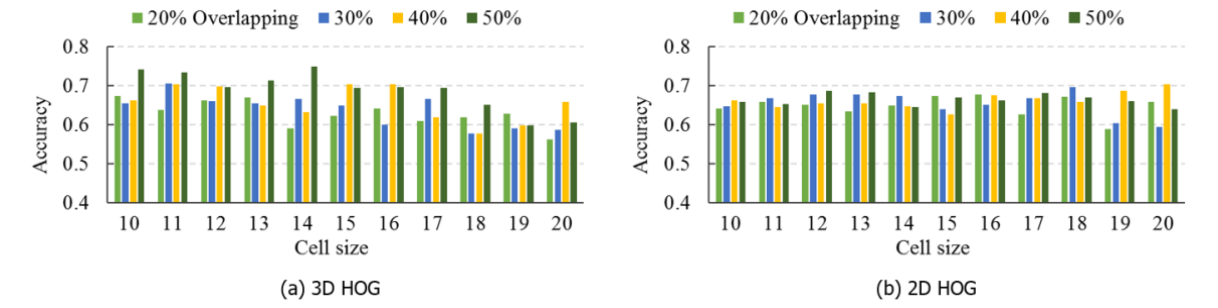
Figure 6. Classification accuracies for the NYU Langone Medical Center: Sample 1 dataset using a 3D histogram of oriented gradients (HOG; a) and 2D HOG